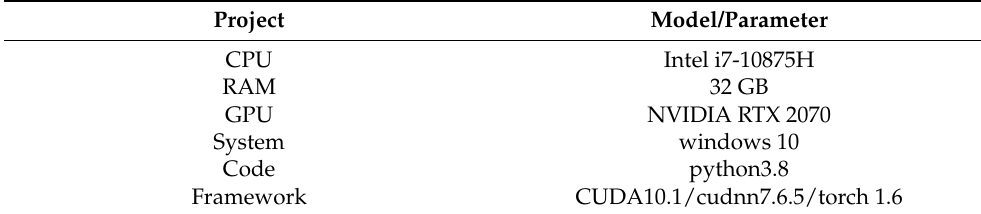
Table 4. Experimental environment. Project